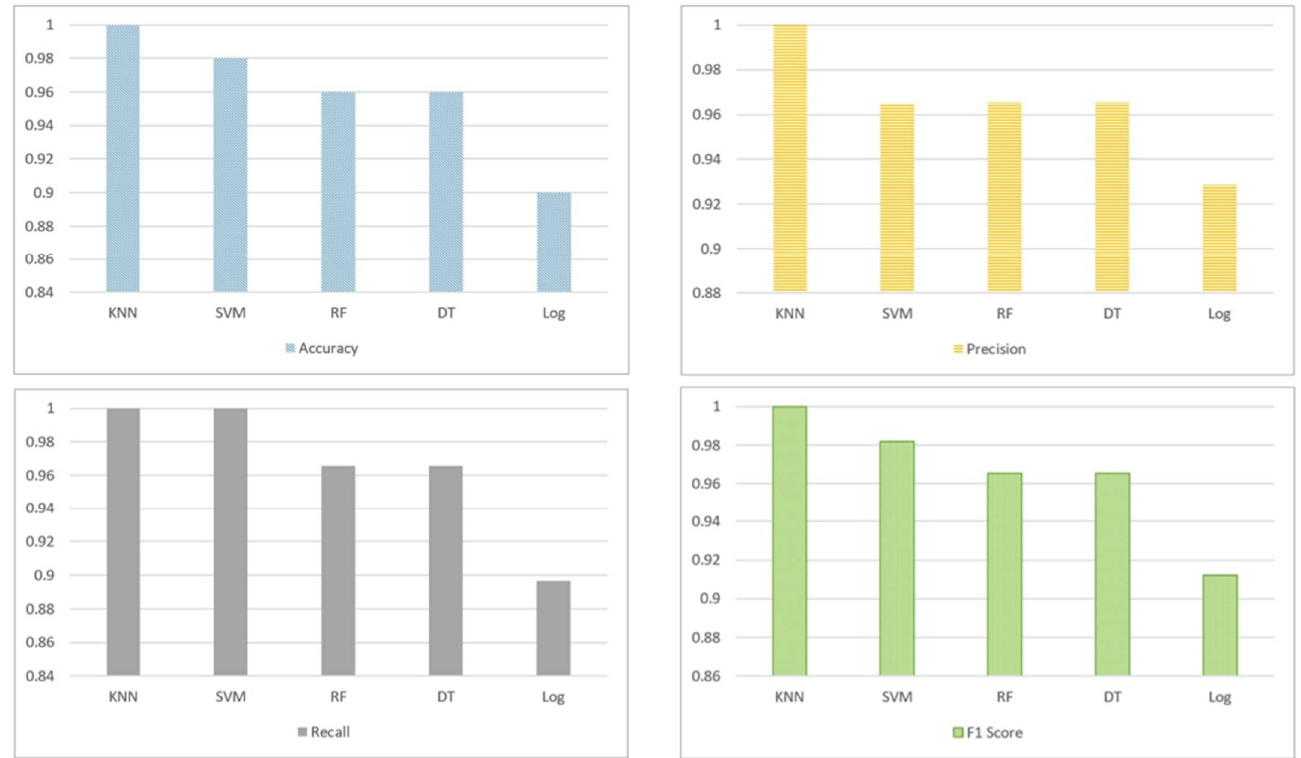
Figure 8. Comparative performance results of the matchmaking algorithm (Algorithm 2) using the one-vs.-all strategy (KNN, SVM, RF, DT, and LogR). Measured metrics include accuracy, precision, recall, and F1 score.